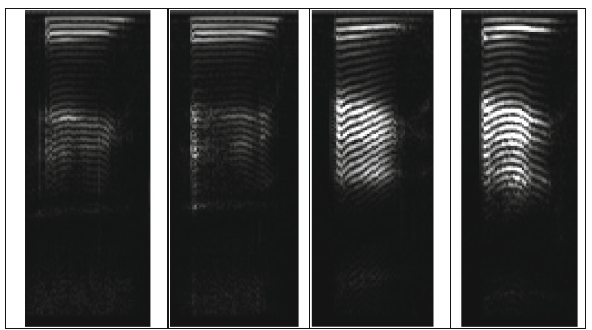
Fig. 1 Spectrogram images of the English alphabet A from four dif- ferent speakers